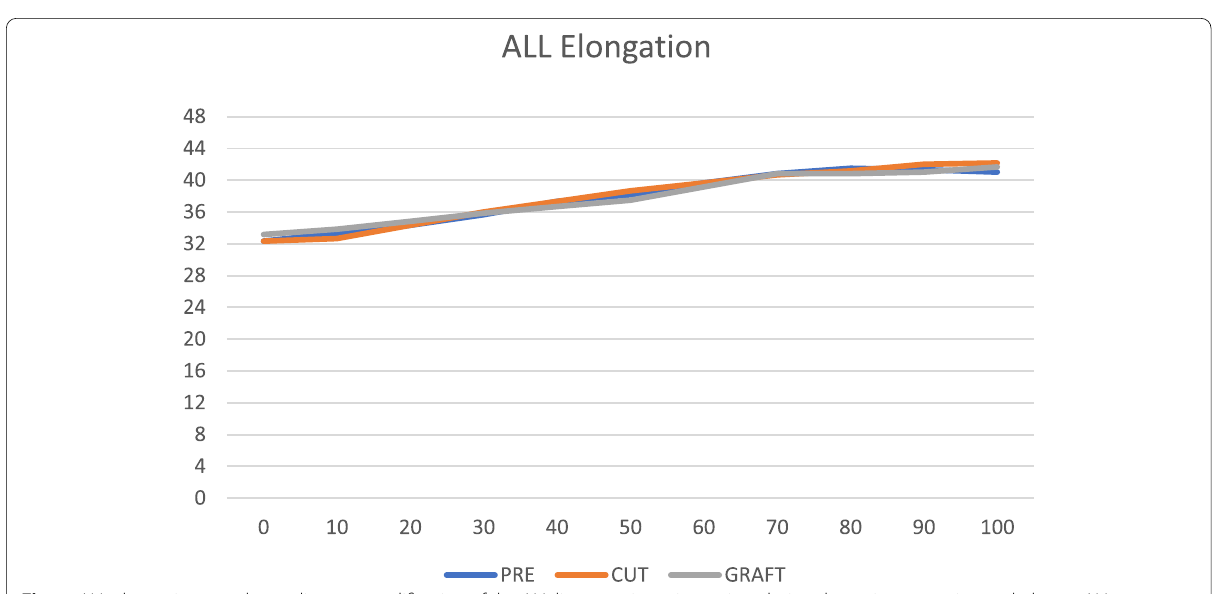
Fig. 5 ALL elongation test shows distance modification of the ALL ligament insertion points during the various experimental phases. ALL appears to have an extension to flexion elongation length ranging from 33 mm (in extension) to 40 mm (at 100° of flexion). There were no statistically significant elongation differences between native ALL and reconstructed ALL (graft) during laxity